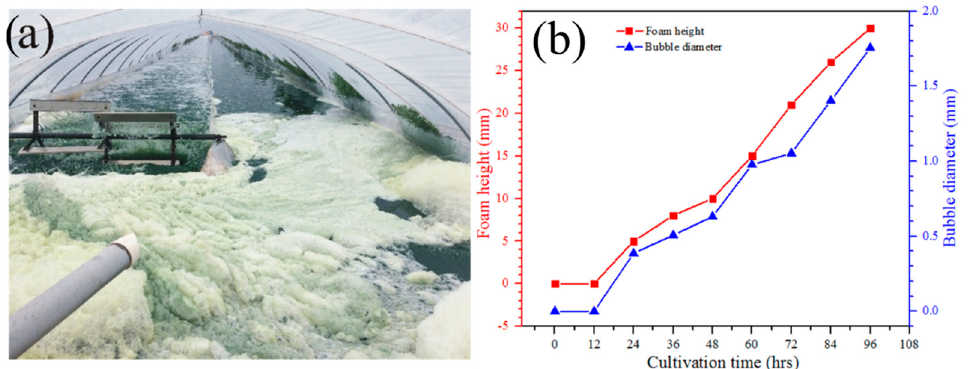
Figure 4. ( a ) Foam formation during cultivation of A. platensis cultivation in industrial raceway ponds ( b ) Qualitative and quantitative demonstration of increasing foam height and bubble diameter after 4 days of microalgal growth.